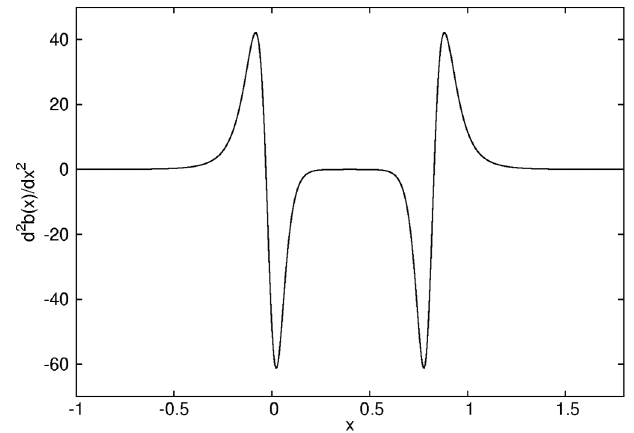
FIG. 3. Field profile for a dipole magnet with a ¼ 0 : 1 , b ¼ ¼ 1 . 0 : 4 , d=a ¼ 0 : 5 , and B 0